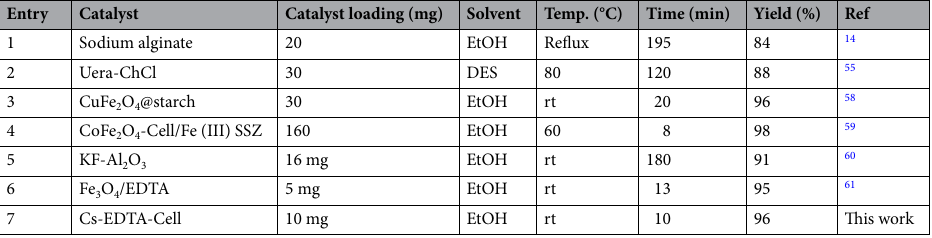
Table 3. Comparative results of the catalytic activity of Cs-EDTA-Cell network ( 1 ) for the synthesis of